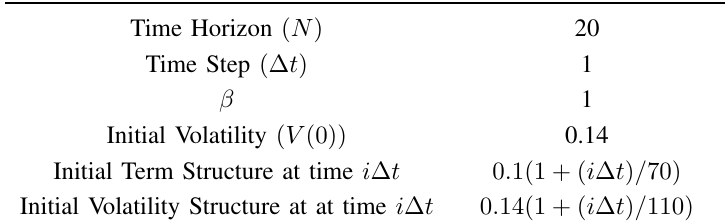
Table 2. Yield curve characteristics.